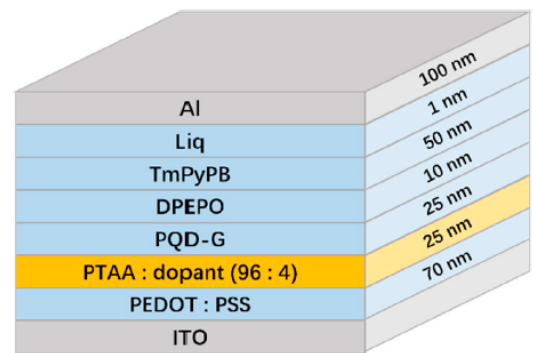
Figure 3. Device structure of the multi-layer stacks used in this investigation.